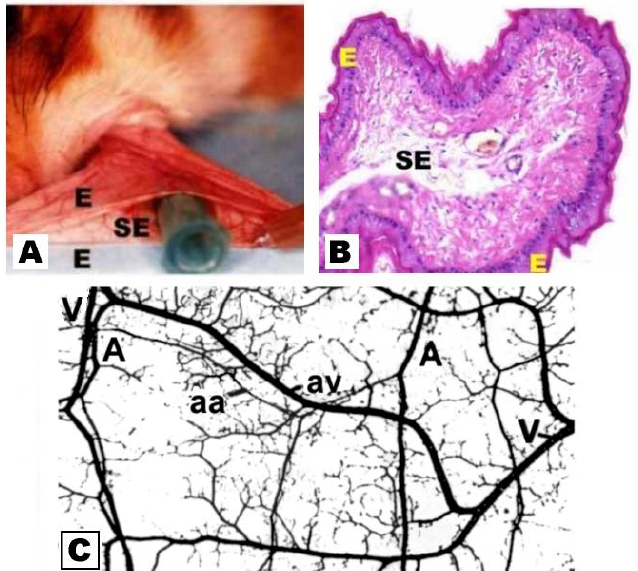
FIGURE 2 – Layers of hamster cheek pouch: macro- and microscopic